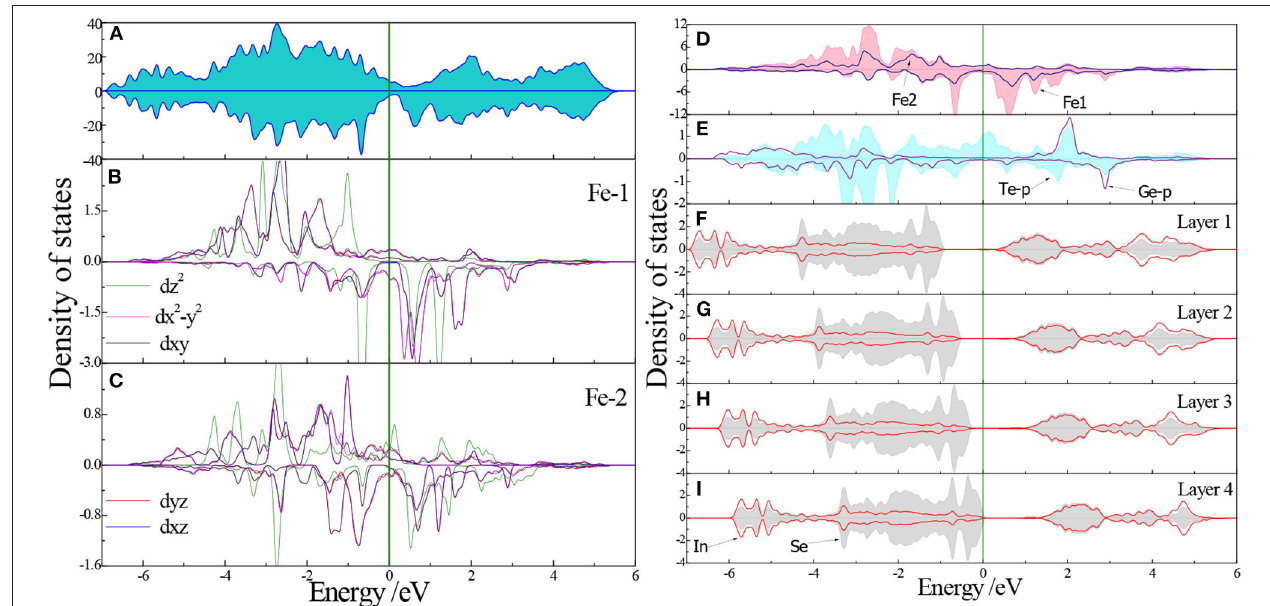
P case (A) ; the partial DOS of the five 3d orbitals for the four Fe1 (B) ; and two Fe2 atoms (C) ; the DOS of FIGURE 4 | Total DOS of the Fe 3 GeTe 2 /In 2 Se 3 HS for the + the inequivalent Fe1 and Fe2 atoms (D) ; the DOS of Te-5p and Ge-4p states (E) ; the layer-resolved DOS of the In 2 Se 3 layers (F–I) .